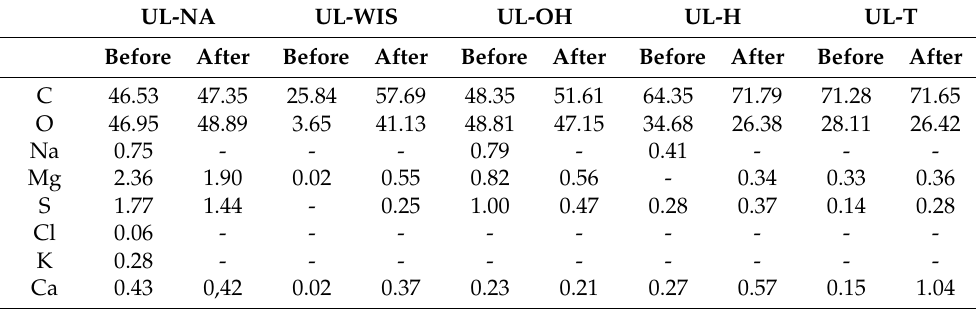
treated (UL-H, UL-OH, UL-T) dry U. lactuca before and after 75 min of contact with methylene blue. UL-NA UL-WIS UL-OH UL-H UL-T Before After Before After Before After Before After Before After